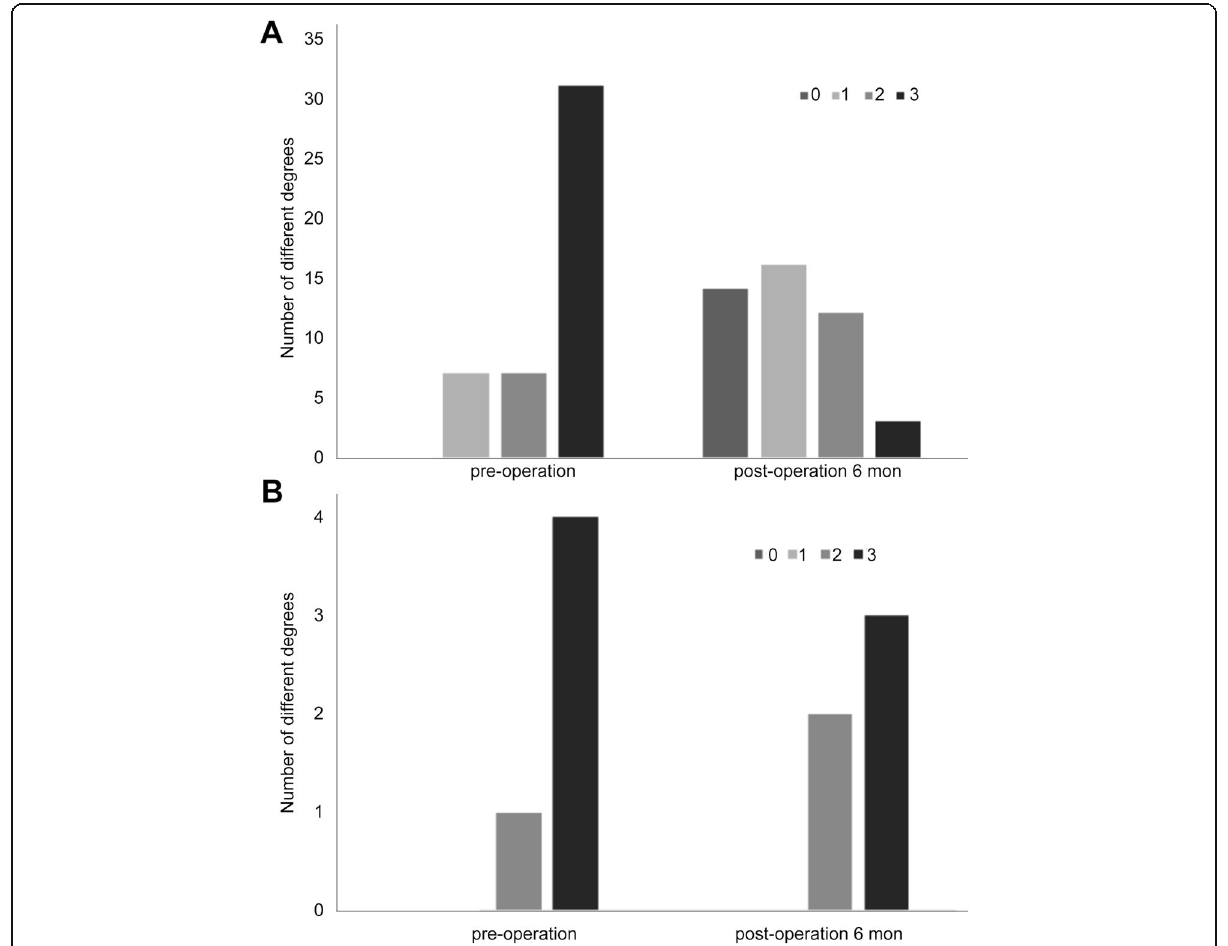
Fig. 3 Degrees of esophagogastric varices in Group A and Group B before and at 6 months after Rex-bypass shunt on gastroscopy. a Group A. b Group